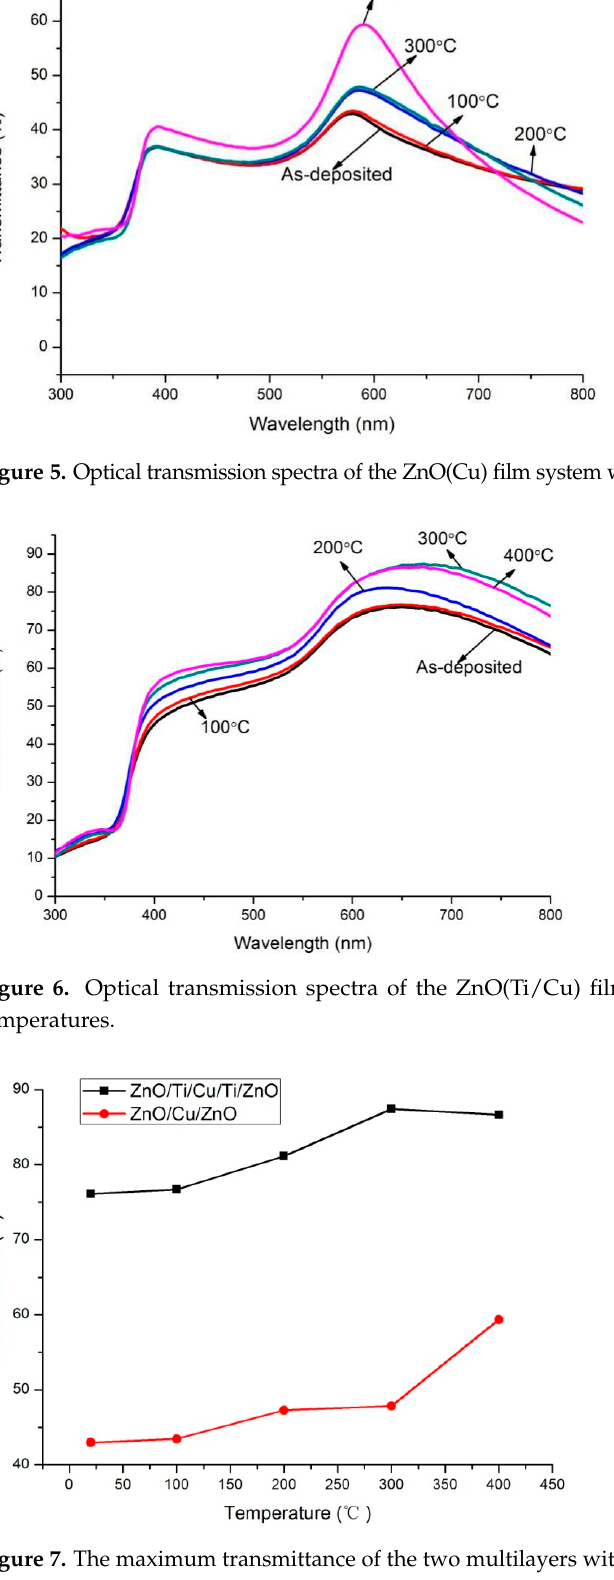
Figure 7. The maximum transmittance of the two multilayers with different annealing tempera- tures.